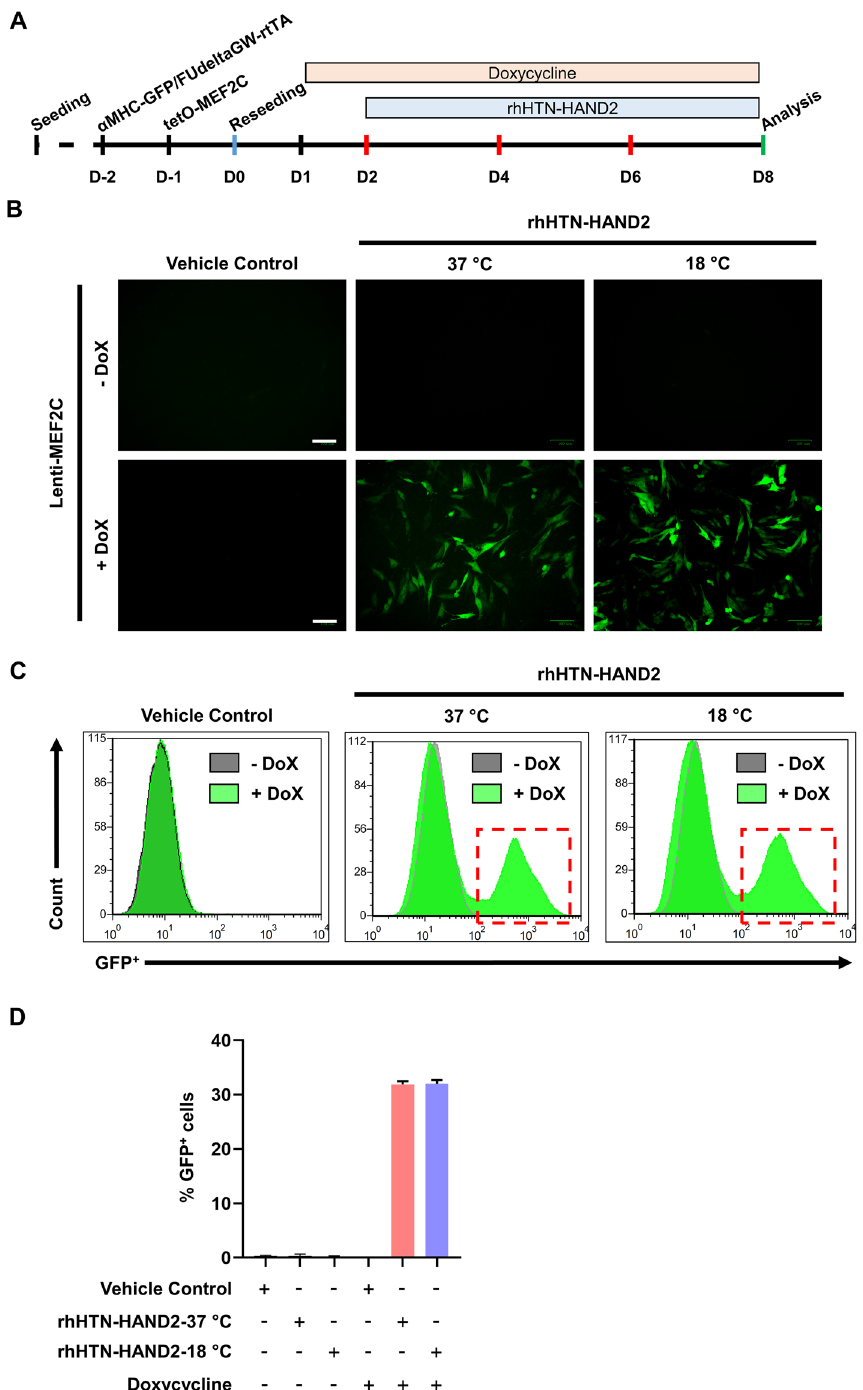
Figure 9. Effect of the purified rhHAND2 fusion protein on synergistic activation of the α-MHC promoter in the presence of MEF2C. ( A ) Schematic representative of the strategy employed to analyze the transcriptional activity of the purified rhHTN-HAND2 protein. ( B ) Firstly, H9C2 cells were transduced with α-MHC-eGFP, FUdeltaGW-rtTA, and tetO-MEF2C viral vectors. Subsequently, they were treated with doxycycline and purified rhHTN-HAND2 protein (induced either at 37 or 18 °C) or vehicle control. After 8 days, images were captured and analyzed. All images were taken with identical camera settings. Scale bar: 100 μm. ( C ) Flow cytometry analysis of GFP + cells. ( D ) Quantitative representation of ( C ). The quantitative data shown are mean ± SEM (n = 4). Dox: